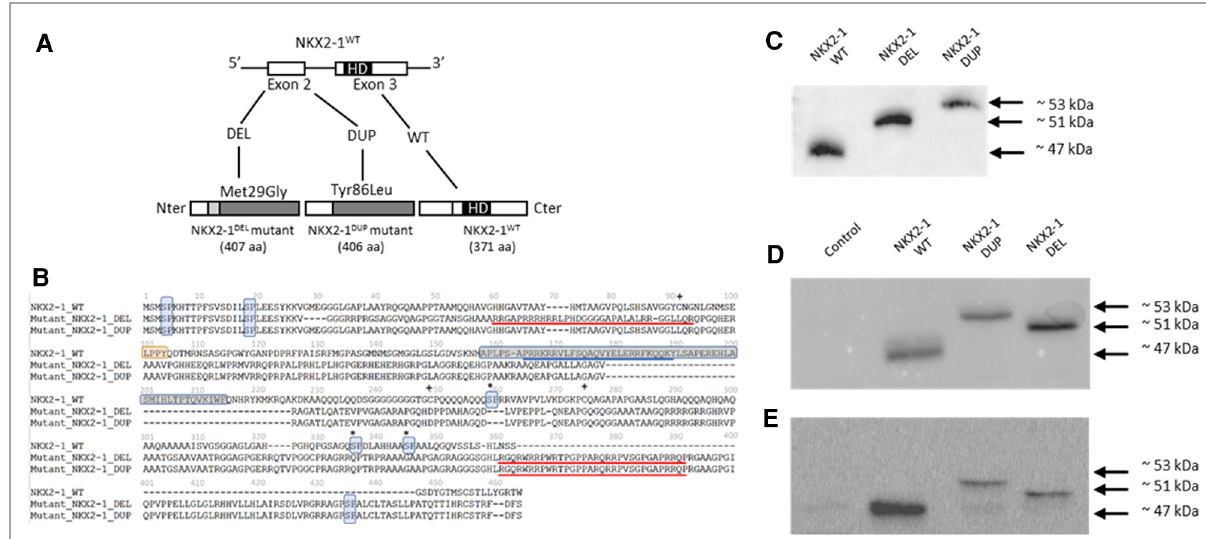
FIGURE 1 ( A ) Identi fi cation of two NKX2-1 pathogenic variant by direct sequencing and expression of the wild-type and mutated NKX2-1 protein. The diagram of the NKX2-1 transcript variant 2 (NM_003317.3) shows the position of the homeodomain and variants. ( B ) Deduced amino acid sequences of NKX2- 1 dup and NKX2-1 del as compared with NKX2-1 WT . The nuclear localization signal (NLS) is underlined in blue for the NKX2-1 WT and the putative NLSs, according to the predictions, are underlined in red for the two mutants. The homeobox domain is framed in gray (position 160 to 220) for the NKX2- 1 WT and is absent for both mutants. pSP motifs have been highlighted in light blue. The NKX2-1 WT harbors fi ve motifs while NKX2-1 del and NKX2-1 dup have three motifs. LPPY motif, a putative TAZ protein interaction motif, has been highlighted in orange for the NKX2-1- WT . This motif is absent for both mutants. Serines involved in phosphorylation in the wild-type sequence but affected by the mutations are marked by an asterisk. Cysteines involved in the dimerization of the amino-acid chains in the wild-type but affected by the mutations are marked by a plus sign (adapted from Moya et al., 2018). ( C ) Representative western blot analysis in pcDNA3-1(+)-TTF1 plasmid of translated NKX2-1 wild type and mutant (DEL and DUP). ( D ) Representative immunoblotting of NKX2-1 in whole cell lysates of A549 cells not transfected (Control) or transiently transfected with NKX2-1 WT , NKX2-1 DUP and NKX2-1 DEL . ( E ) Representative immunoblotting of NKX2-1 in whole cell lysates of Nthy cells non-transfected (Control) or transiently transfected with NKX2-1 WT , NKX2-1 DUP and NKX2-1 DEL